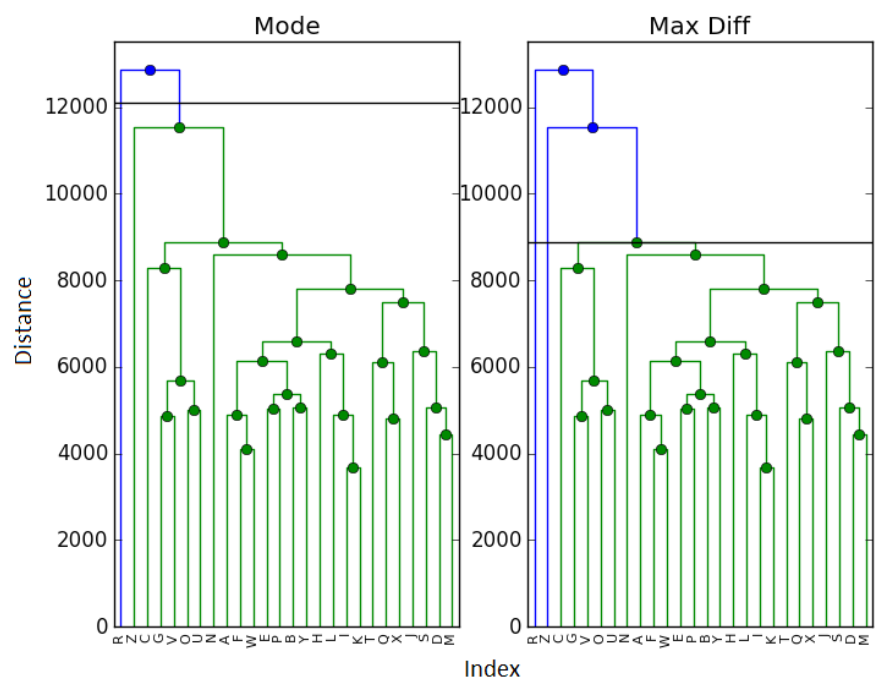
Figure 4. Clustering of the